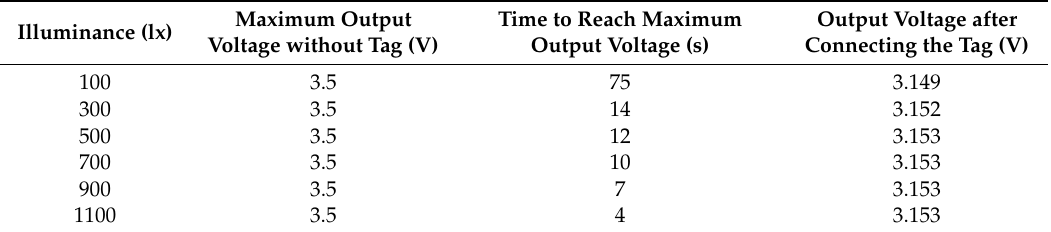
Table 3. Measurements without connecting the tag until the boost converter exits